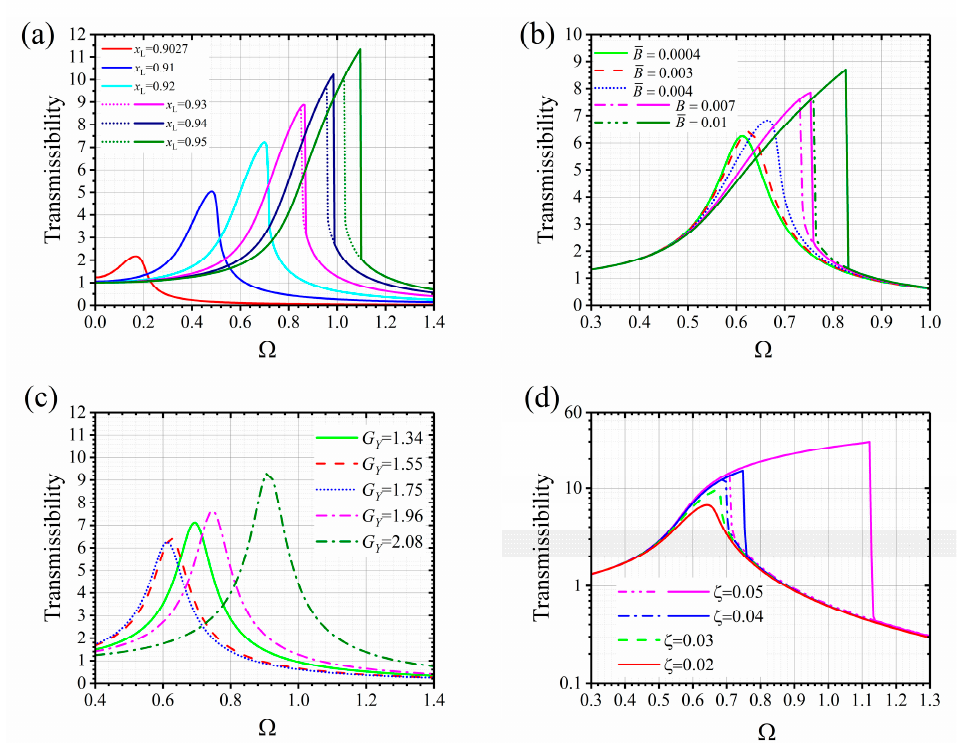
Figure 6. The mathematical simulation results. ( a ) Transmissibility for different nonlinear geometric parameters at the rated load. ( b ) Transmissibility for different excitation displacement amplitudes. ( c ) Transmissibility for different load weights. ( d ) Transmissibility for different damping ratios.